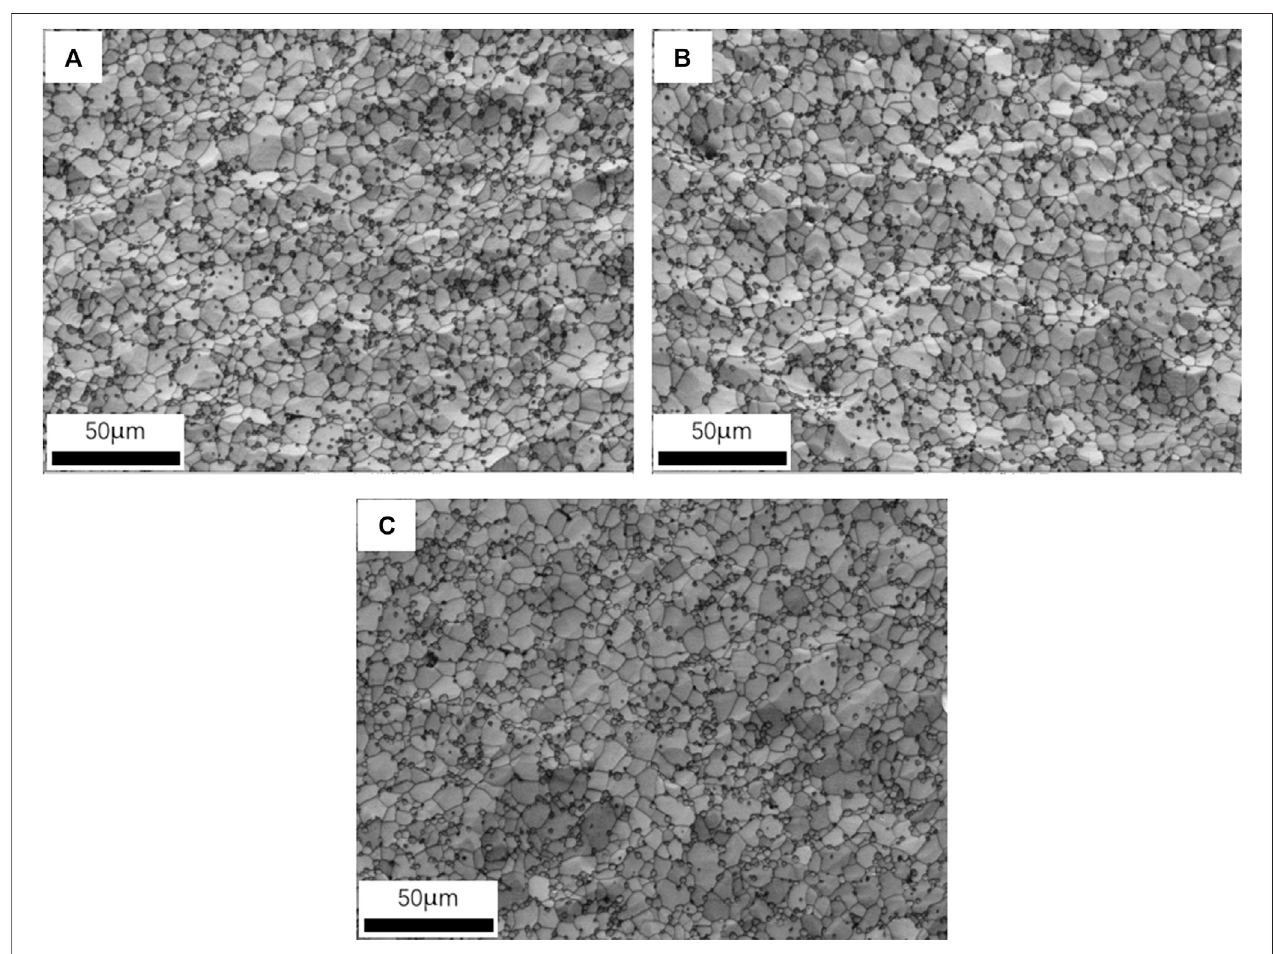
FIGURE 3 | The EBSD band contrast images of the alloy in different conditions, (A) T1, (B) T4, (C) T6.